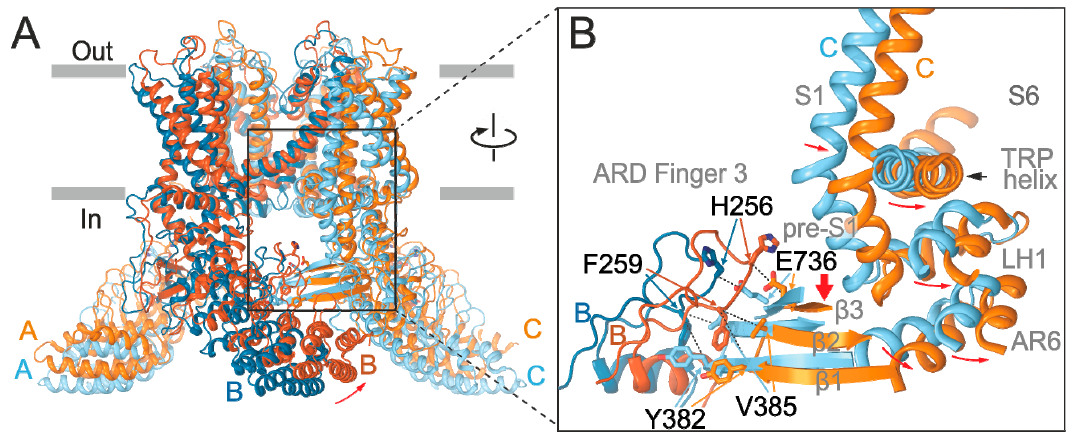
Figure 5. Changes in the β sheet-ARD finger 3 inter-subunit interface during TRPV3 gating. ( A ) Superposition of TRPV3 structures in the closed (PDB ID: 6DVW; subunits A and C are colored cyan, B blue) and open (PDB ID: 6DVZ; subunits A and C are colored orange, B brown) states. The structures are aligned based on their pore domains. The upward movement of the ARD during opening is illustrated with the red arrow. ( B ) Close up view of the β sheet-ARD finger 3 interface between subunits B and C. Sliding down motion of the three-stranded β sheet relative to the ARD finger 3 during TRPV3 opening is illustrated with the thick red arrow. Thin red arrows illustrate movements of the domains that link β sheet to the gate formed by S6. Flexible loops connecting these domains are omitted for clarity. Distances between C α atoms of cysteine-substituted pairs F259/Y382, F259/V385, and H256C/E736C (black dashed lines) are 8.3 Å, 6.6 Å, and 7.3 Å in the closed state and 9.6 Å, 7.3 Å, and 8.1 Å in the open state,